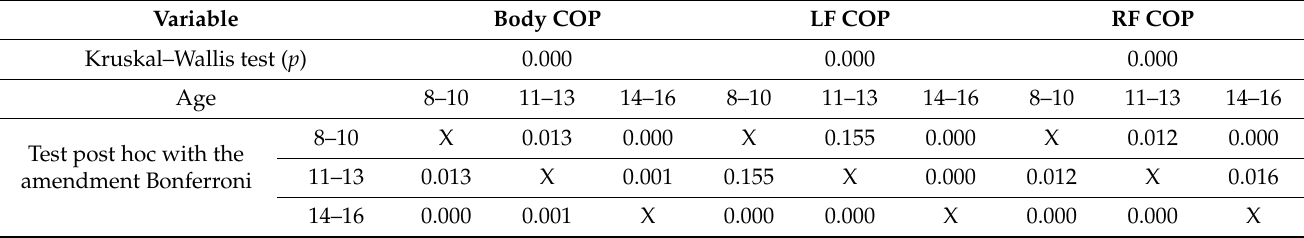
Table 5. Significance of the changes in the position of the center of gravity between the studied age groups.